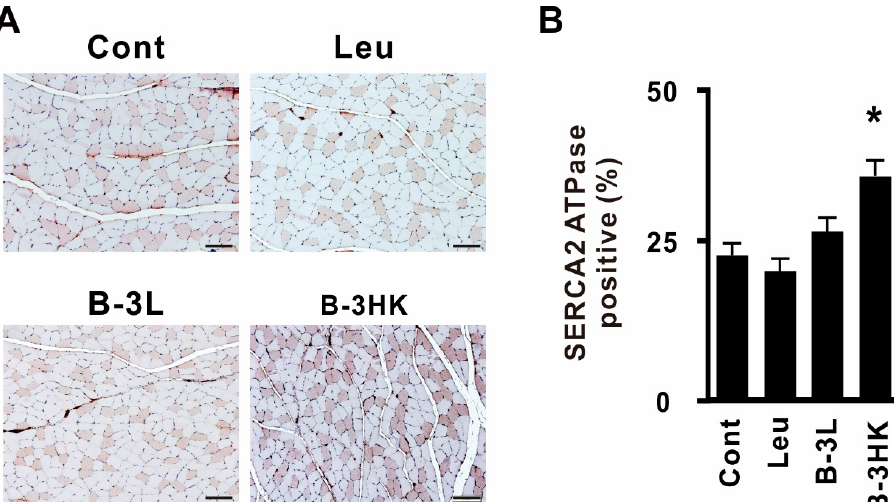
Figure 5. B-3 promoted the switching of type 1 fibers through the AMPK signaling pathway in rats. ( A ) Representative results of immunohistochemistry against SERCA2 ATPase in the rat medial gastrocnemius. The scale bar represents 100 µm. ( B ) The mean percentage of SERCA2 ATPase-positive fibers was determined among 450 fibers in three sections per rat ( n = 7). Statistical differences were analyzed for significance using the Steel–Dwass test (* p < 0.05, versus control). The data are expressed as the means and SEs.